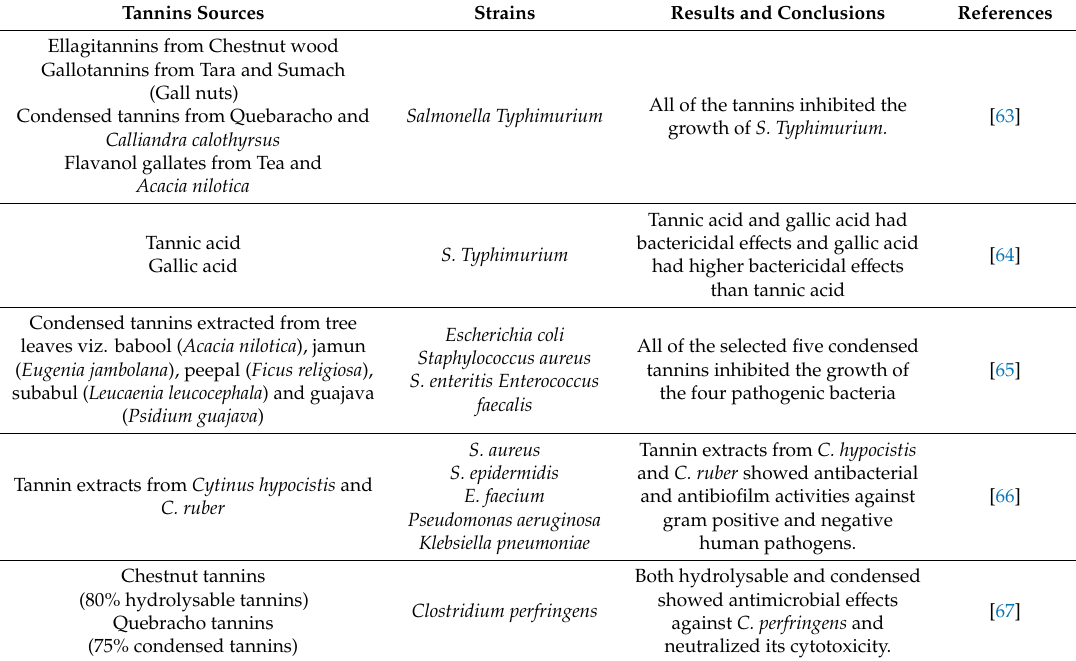
Table 2. In-vitro antimicrobial e ff ects tannins against diverse pathogenic bacteria. Tannins Sources Strains Results and